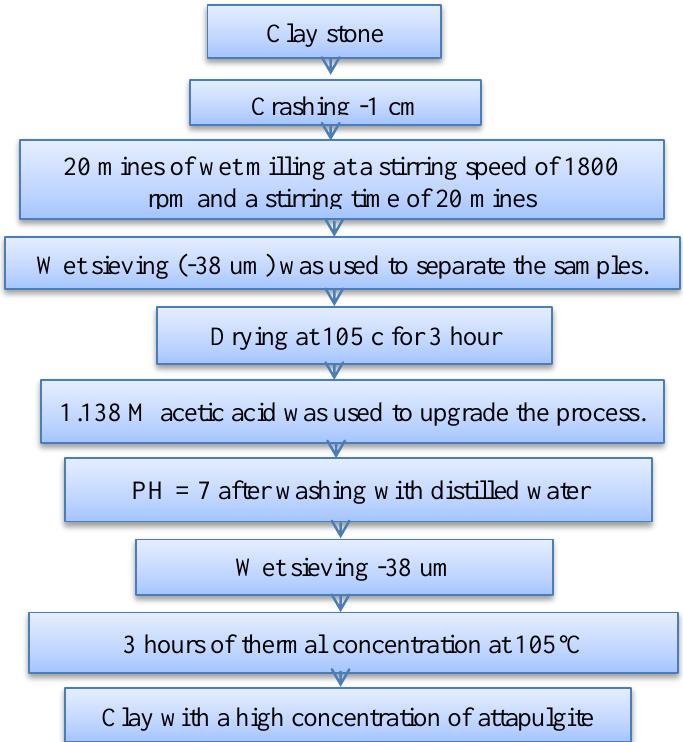
Figure 1: The flow chart for attapulgite acid treatment.